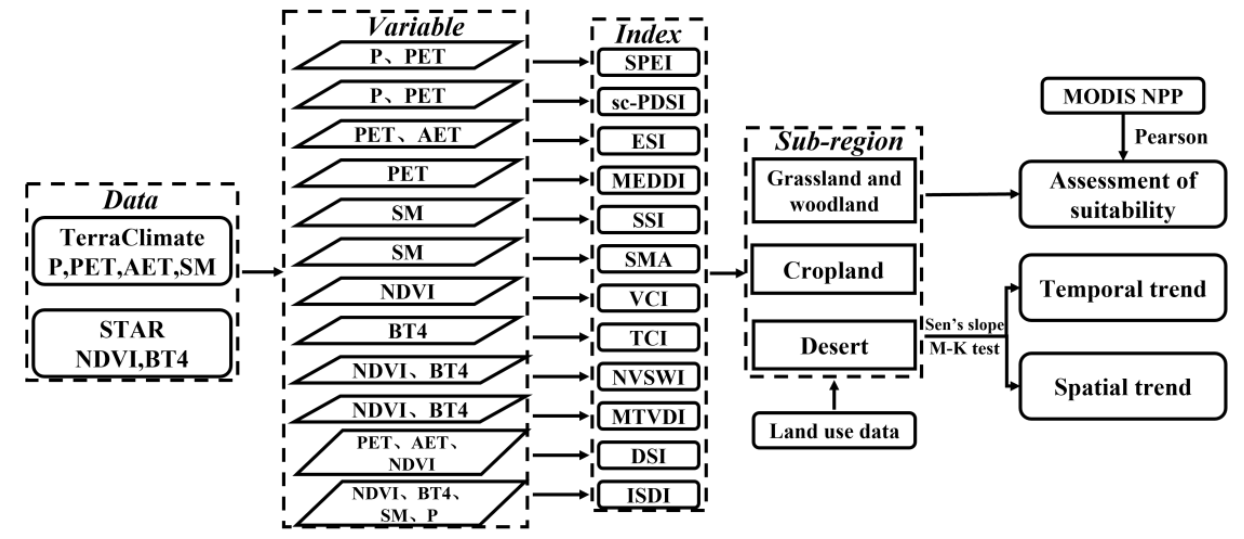
Figure 2. Flow chart of calculation and analysis of this study.